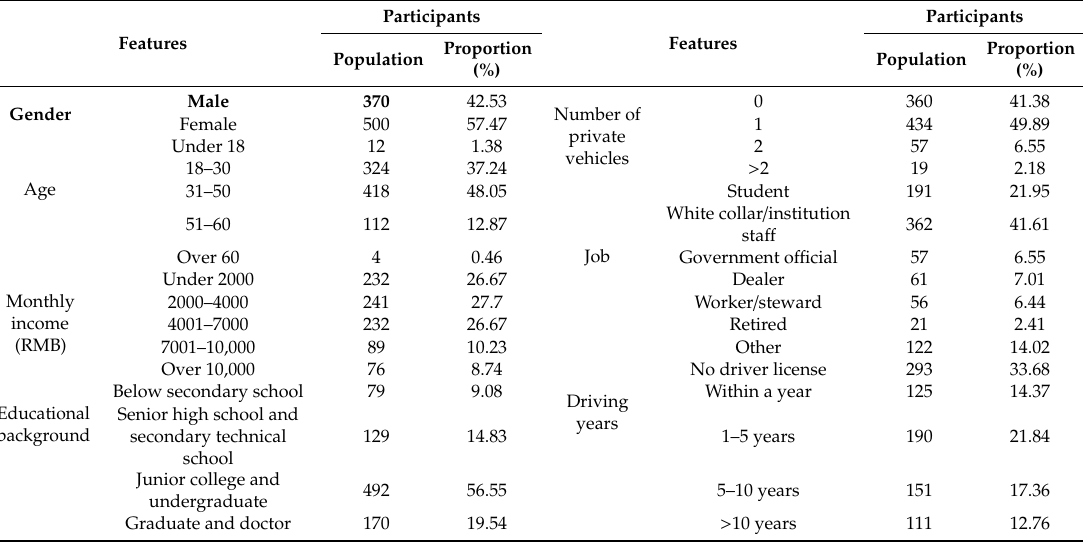
Table A3. Characteristics of participants of 870 valid samples.